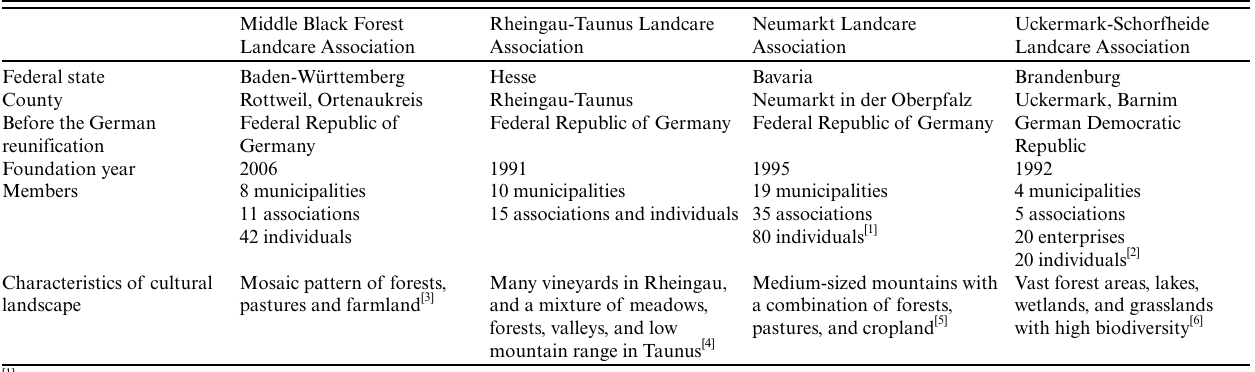
Table 2. Characteristics of the landcare associations Middle Black Forest Landcare Association